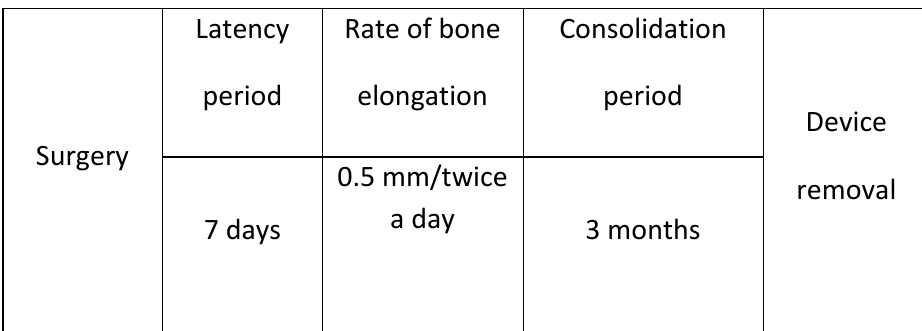
Table 1: Protocol for gradual alveolar distraction osteogenesis of the posterior mandible prior to Device removal.